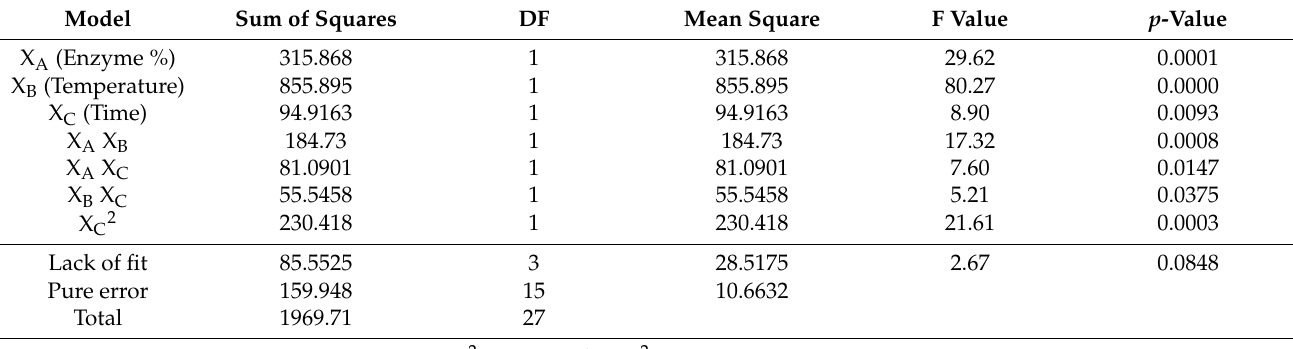
Table 4. Analysis of variance (ANOVA) for ACE inhibition (%) obtained for the subtilisin Box-Behken design.